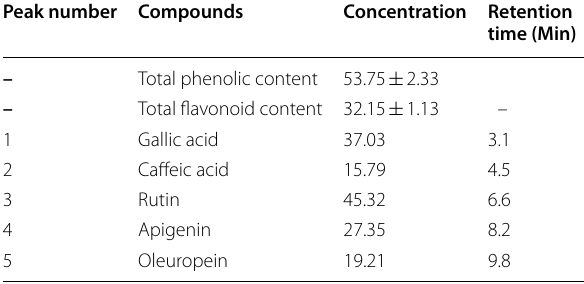
Table 2 Amount of total phenolics a , flavonoids b and the qualitative–quantitative analyses c of the ethanol extract from OL carried out using an